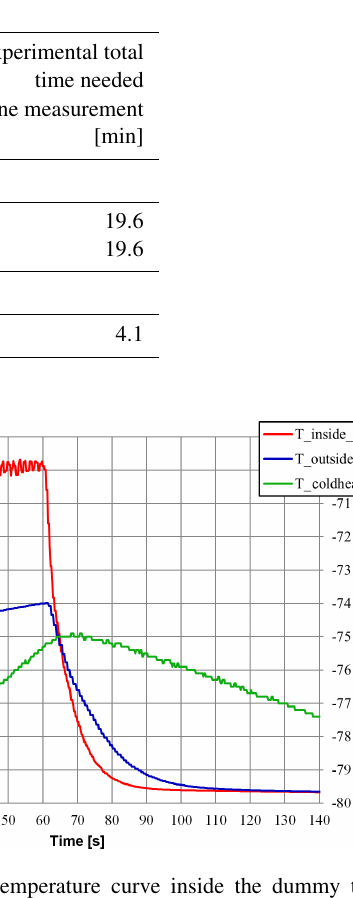
Table 2. Cycle times at T A of − 80 ◦ C / − 120 ◦ C (laboratory set-up) and − 70 ◦ C (in situ set-up), based on operational data. Laboratory set-up configuration: Sunpower CryoTel CT Stirling cooler, preconcentration volume: 500mL at 100mLmin − 1 , T D ≈ 200 ◦ C for 3min. In situ set-up configuration: Twinbird SC-TD08 Stirling cooler with preconcentration volume of 100mL at 100mLmin − 1 , T D ≈ 200 ◦ C for 1min. Adsorptive material in both set-ups was HayeSep D. Due to a smaller coldhead, cooling rate and warm-up during desorption are considerably larger with the in situ set-up, despite the shorter desorption time.